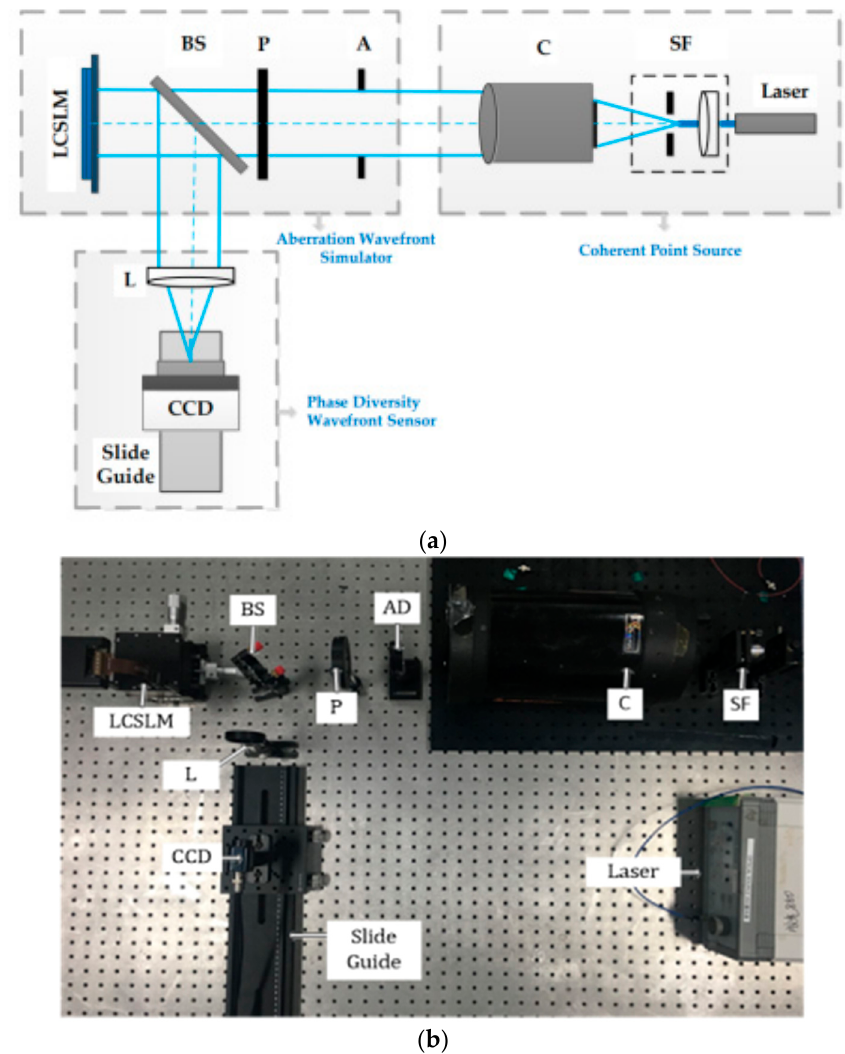
Figure 8. The schematic diagram ( a ) and physical map ( b ) of the optical system used in the experiment. P: Polarizer, SF: Spatial filter, C: Collimator, AD: Aperture stop, BS: 1:1 Spectroscope, CCD: Imaging detector, L: Lens.